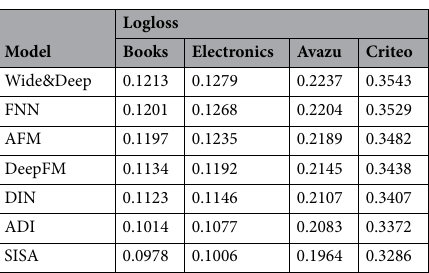
Table 2. Overall CTR prediction for Logloss performance in different